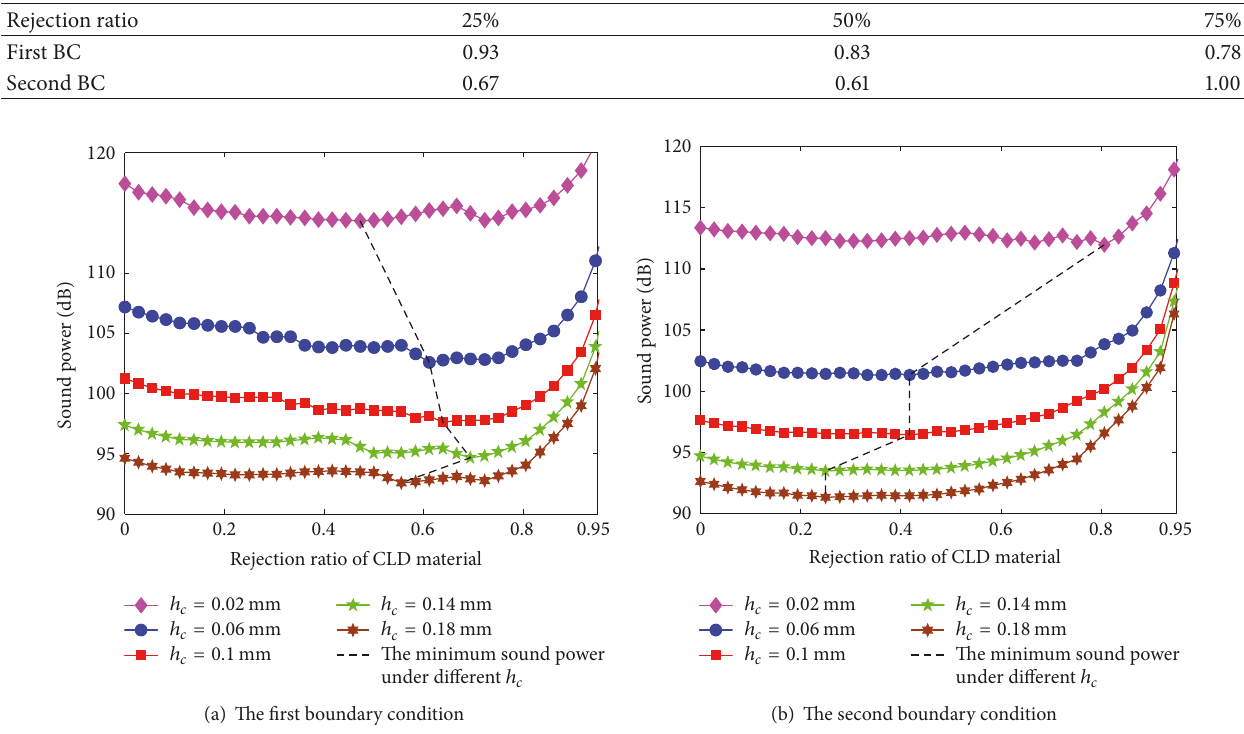
Table 6: Consistency ratios of optimal CLD layouts using ESO and GA.